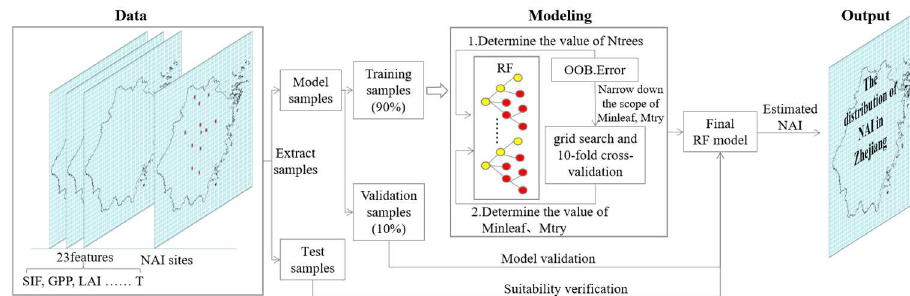
Figure 2. Flowchart of NAI estimation based on RF algorithm.